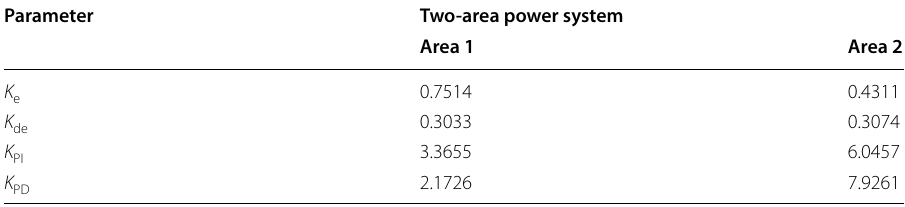
Table 8 WCA optimal values of fuzzy controller